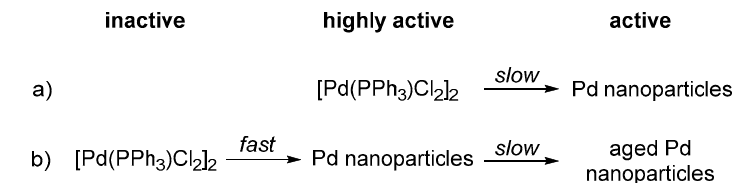
Scheme 1. Schematic representation of possible mechanisms for formation of the active catalyst